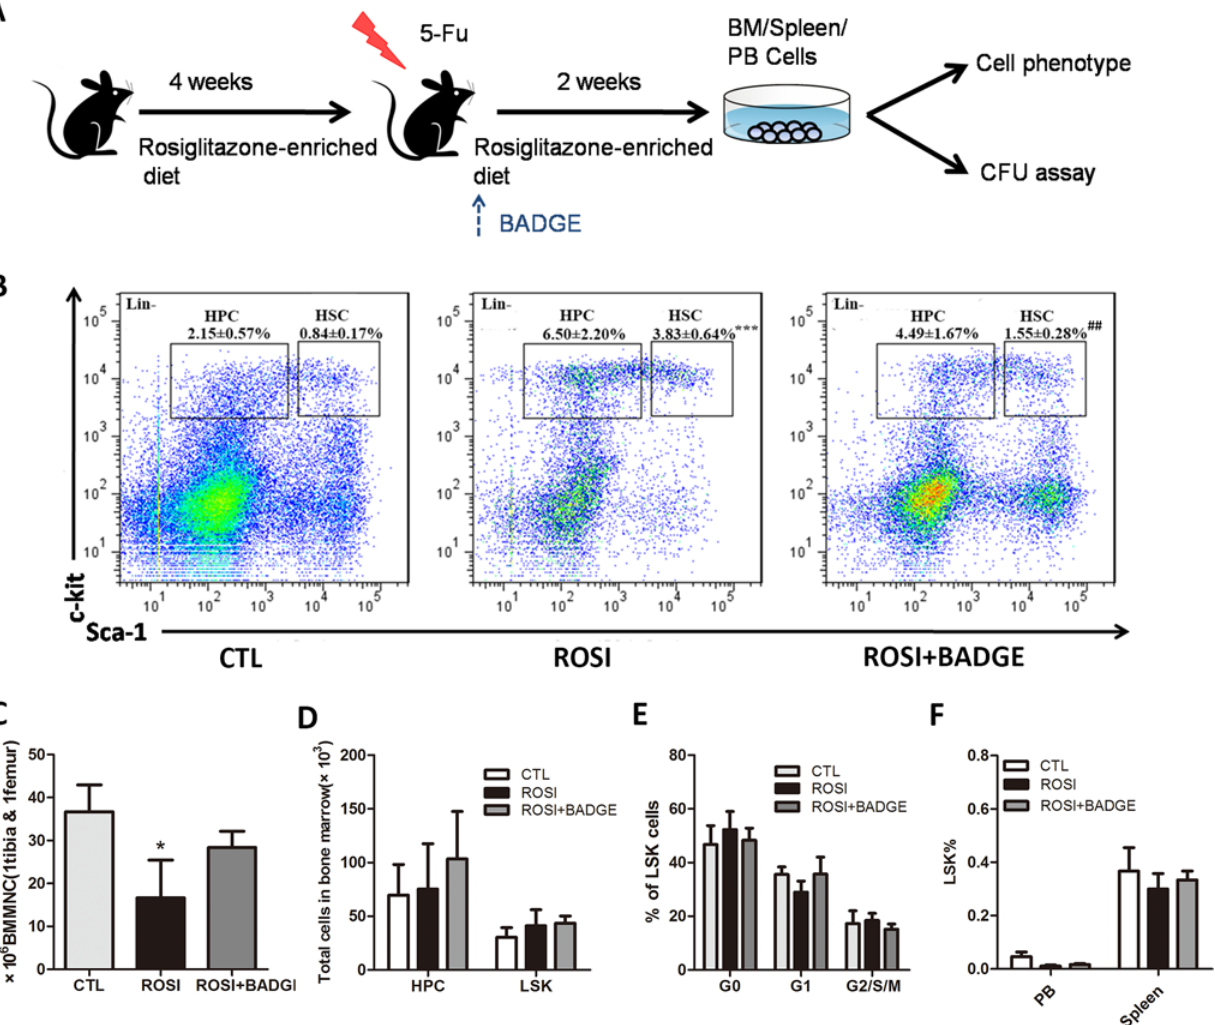
Fig 3. The in vivo effect of rosiglitazone treatment on LSK cells in bone marrow, peripheral blood and spleen under stress conditions. (A) Schematic of the experiment. In brief, the mice were fed a diet with or without rosiglitazone for 4 weeks. Then, they received a single dose of 250 mg/kg 5-Fu and continued their rosiglitazone-enriched or normal diet for two weeks. Two weeks after chemotherapy, the bone marrow, spleen and PB cells were isolated and used for flow cytometric analysis or a CFU assay. (B) Flow cytometric analyses of the LSK and HPC populations in the BM 14 days after 5-Fu. (C)The number of BMMNCs in rosiglitazone-treated mice was dramatically reduced compared to control mice 14 days after 5-Fu treatment. (D) The absolute number of HPC and LSK cells in the BM 14 days after 5-Fu treatment. (E)Cell cycle analysis of LSK in BM. (F)Flow cytometric analysis of the proportion of LSK cells in the PB and spleen 14 days after 5-Fu treatment. The data are presented as the means ± SD of three independent experiments, * P < 0.05 compared to CTL, *** P < 0.001 compared to CTL, ## P < 0.01 compared to